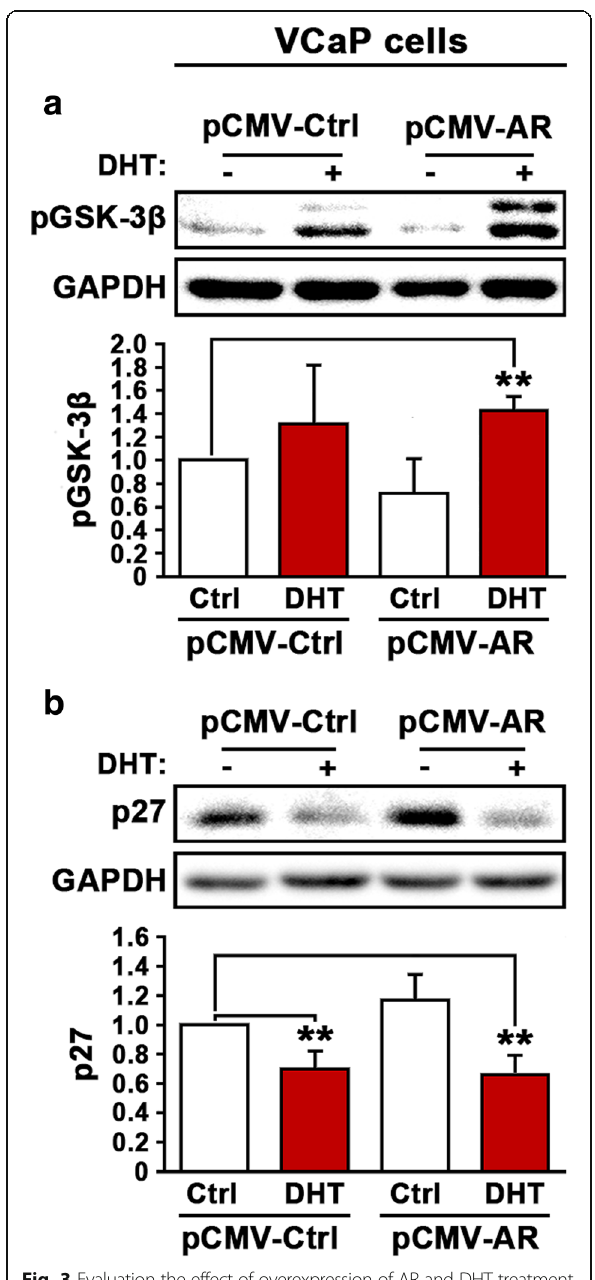
Fig. 3 Evaluation the effect of overexpression of AR and DHT treatment on EGFR-related downstream effectors of AKT. a Immunoblot analysis was performed to examine the expression of p-GSK-3 β in VCaP cells that were transfected with pCMV control or pCMV-AR vectors followed by treatment with DHT or vehicle control. b . Immunoblot analysis was performed to examine the expression of p27 in VCaP cells that were transfected with pCMV control or pCMV-AR vectors followed by treatment with DHT or vehicle control. Antibody against GAPDH was used as loading control. Data presented is average of three independent experiments (±SD). p <0.05 is indicated by “ * ” , p ≤ 0.01